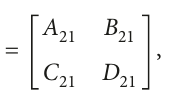
planar Lyapunov orbit ( amplitude = 4,000km ); (b) L 1 planar long periodic orbit ( amplitude = 5,000km 4